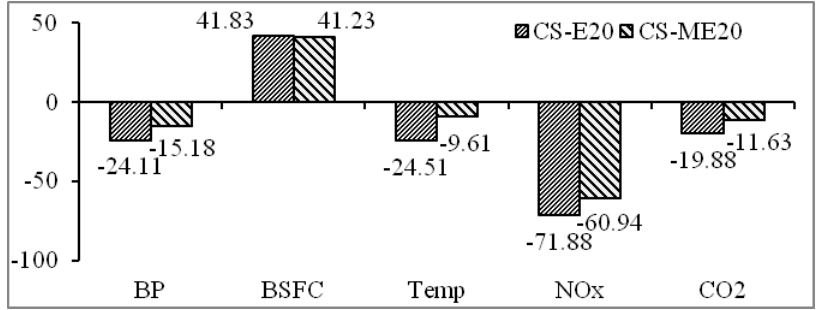
Figure 11. Engine performances differences than CS-B100 when CS-E20 and CS-ME20 are used at engine speed 3670